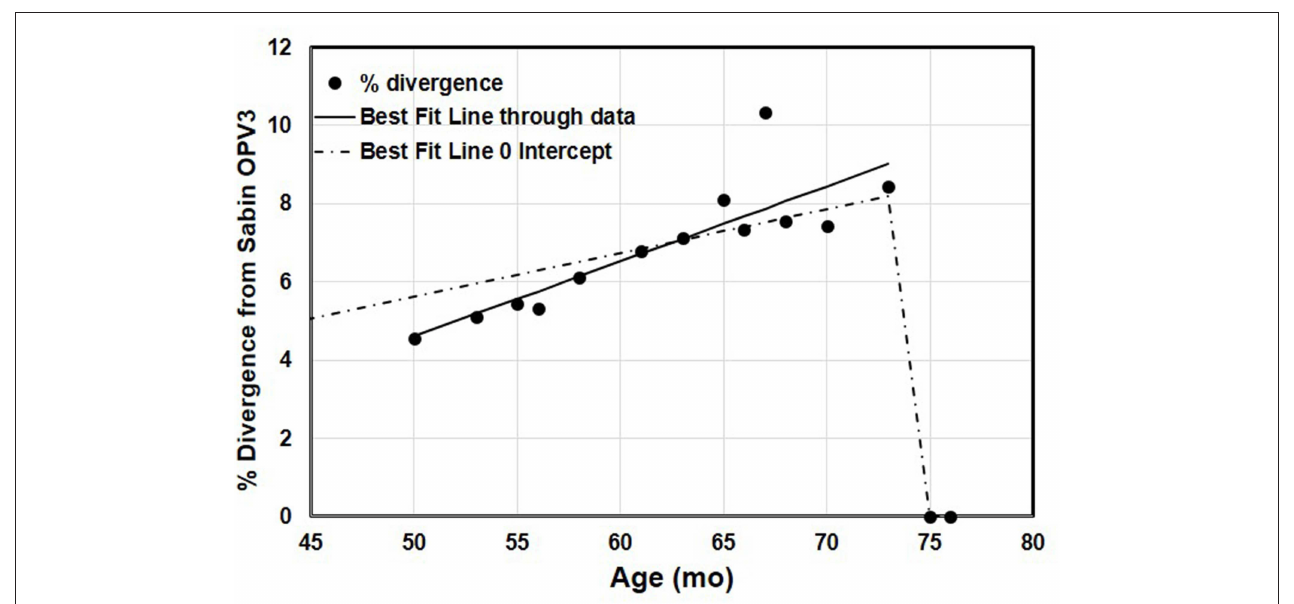
FIGURE 1 | The accumulation of changes in the VP1 genomic region of 13 sequential poliovirus type 3 isolates under study. The actual observed data and the variability of the repeated measurements over the time of observation have been indicated. The data were adjusted to linear functions for the accumulation of substitutions. The two lines show the best-fitting linear trend to the observed positive data with and without an intercept. The line with no intercept implies infection at the time of birth, because it goes through 0% divergence at age 0. The better-fitting line with the intercept shows a steeper increase in divergence. Regression with intercept: equation for the line: estimated % divergence while excreting Y = 0.112 x , x = age (months), Y = estimated % divergence, R 2 = 0.85. Regression without intercept: equation for the line: estimated % divergence while excreting Y = 0.192 x – 5, where x = age (months), Y = estimated % divergence, R 2 =